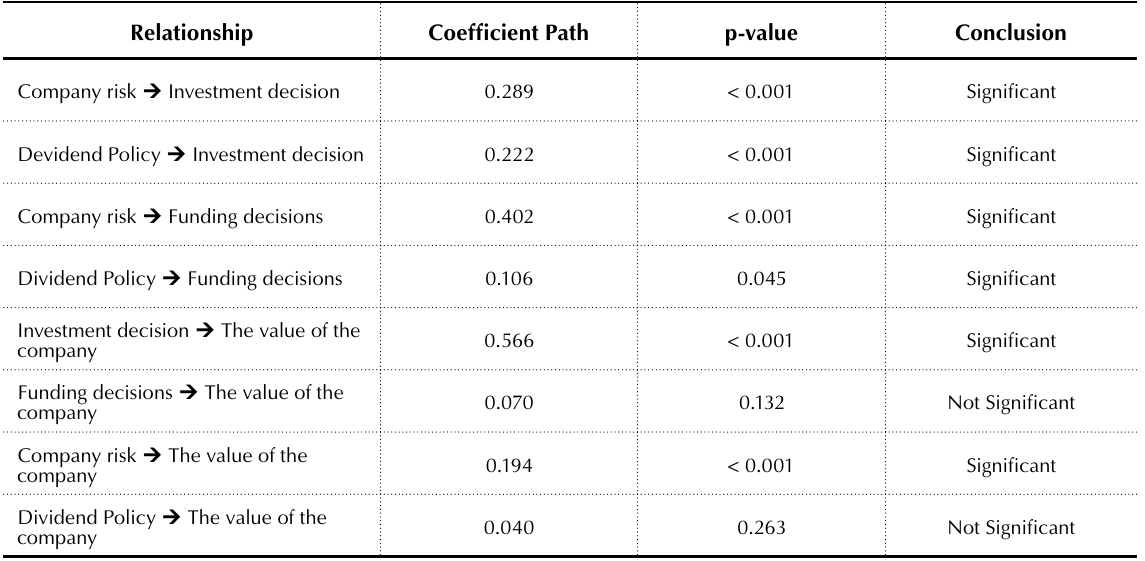
Table 3. The results of Hypotheses Testing in Inner Model: Indirect Influence